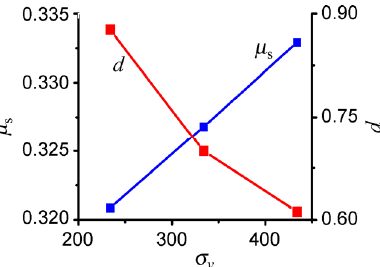
Fig. 3 Scratch friction coefficient d with an increase of the yield strength  0.8 N F  in the cases when the substrate has the same material n properties as the coating.